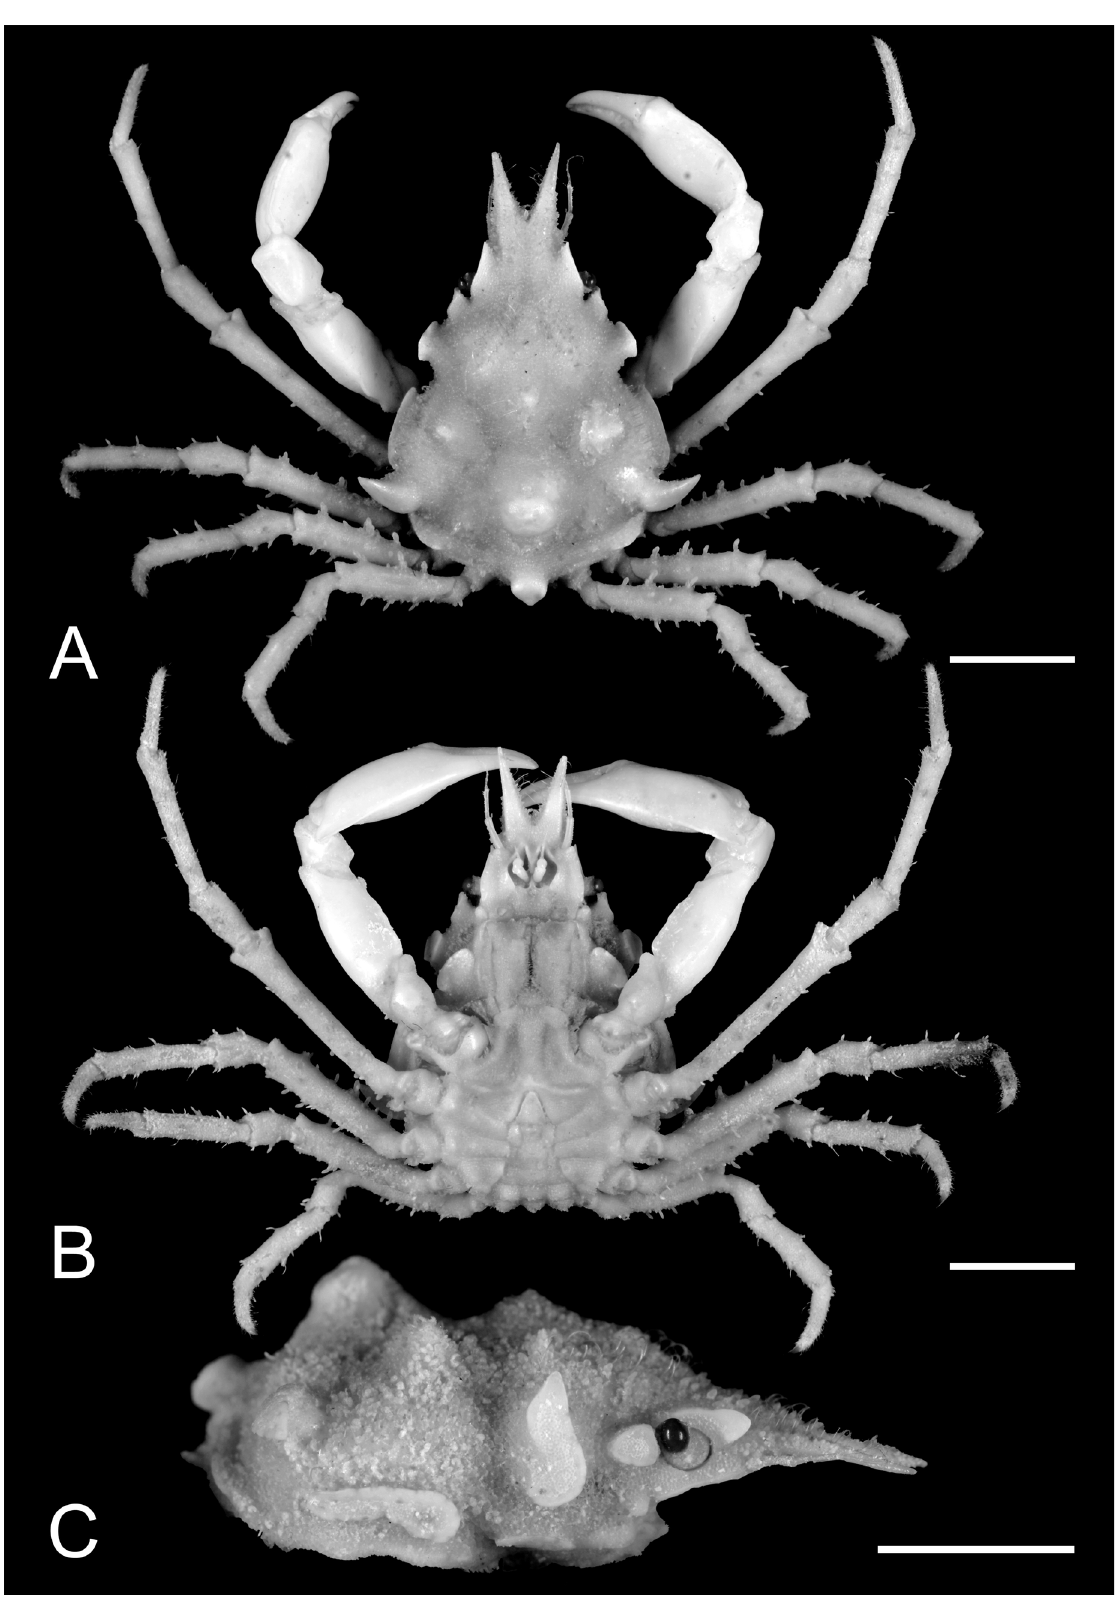
Fig. 5. Oxypleurodon leonis sp. nov., holotype, ♂ (13.5 × 9.0 mm) (NTOU), South China Sea. A . Overall dorsal view. B . Overall ventral view. C . Lateral view of carapace. Scale bars = 5